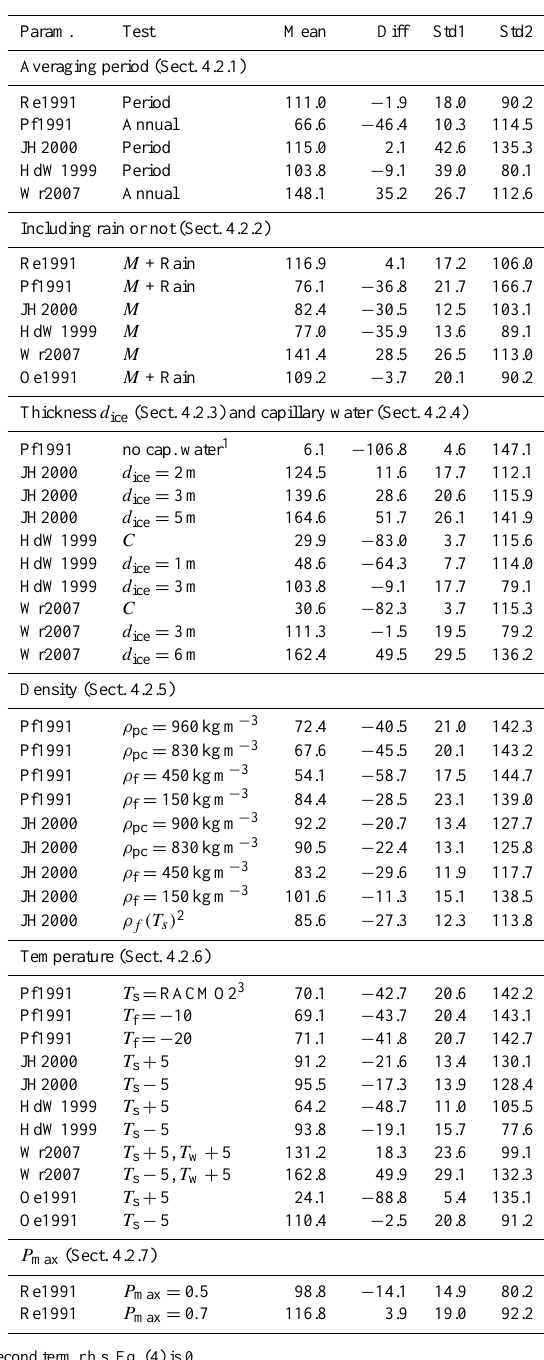
Table 3. Tests of the input variables of the parameterizations. RACMO2 input fields are used. Reference statistics are given in Ta- ble 2. Headings are as in Table 2, Diff and Std2 are with respect to RACMO2 refreezing, test refers to change compared to reference, numbers between brackets denote sections where experiments are